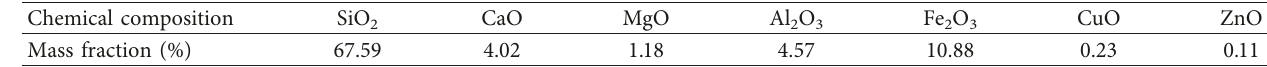
Table 2: Main chemical composition of iron tailings powder.